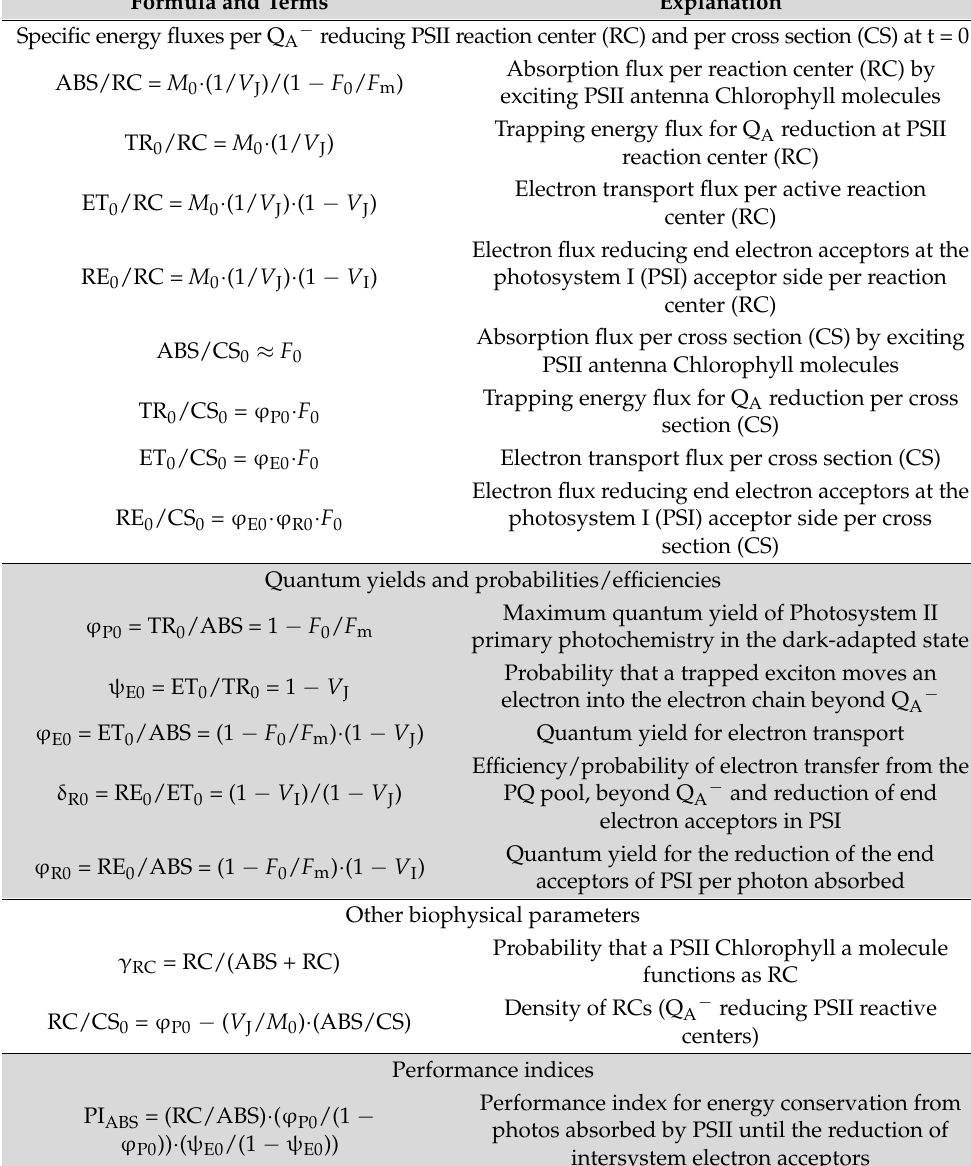
Table 1. Cont. Formula and Terms Explanation Specific energy fluxes per Q A − reducing PSII reaction center (RC) and per cross section (CS) at t =